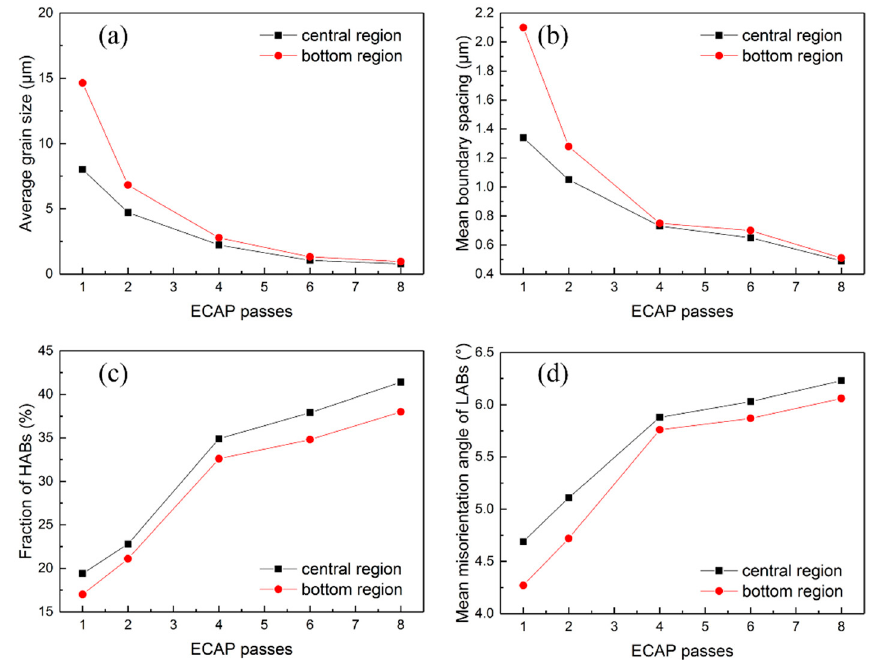
Figure 6. Microstructure information in the central and bottom regions on the longitudinal section of the ECAPed Cu-Mg alloy: ( a ) average grain size, ( b ) mean boundary spacing, ( c ) fraction of high-angle boundaries (HABs) and ( d ) mean misorientation angle of low-angle boundaries (LABs).